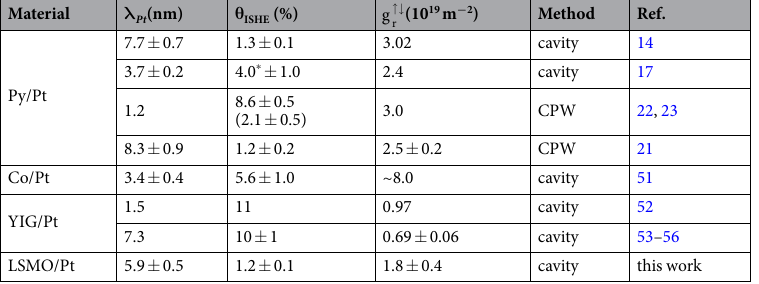
Table 2. Spin diffusion length, spin Hall angle and spin mixing conductance from various research groups are listed. * The original value in ref. 17 is 0.08 due to a difference in the spin Hall angle definition resulting into a factor of 2. (coplanar waveguide =